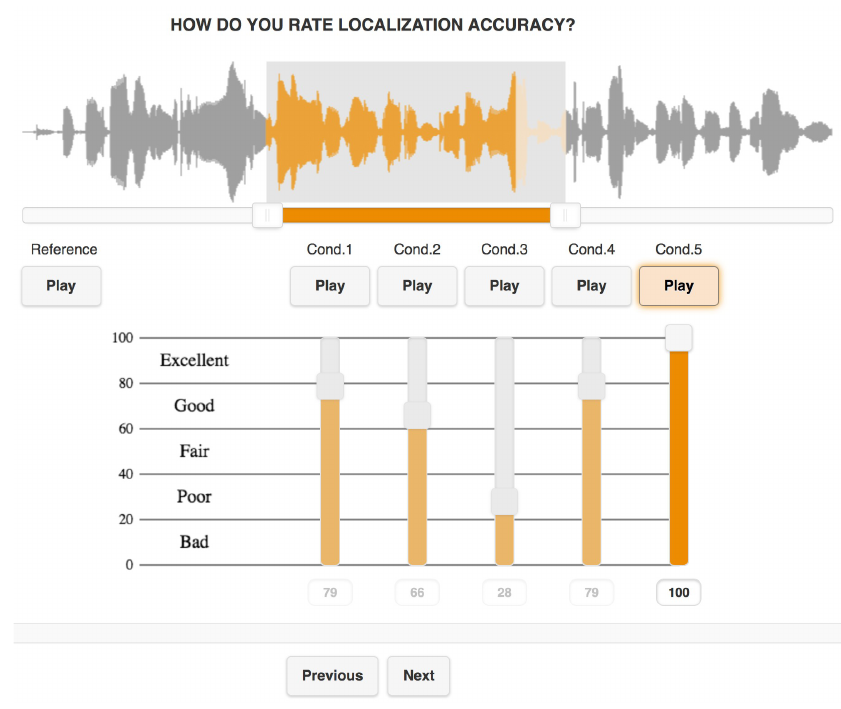
Figure 2. WebMUSHRA Graphical User